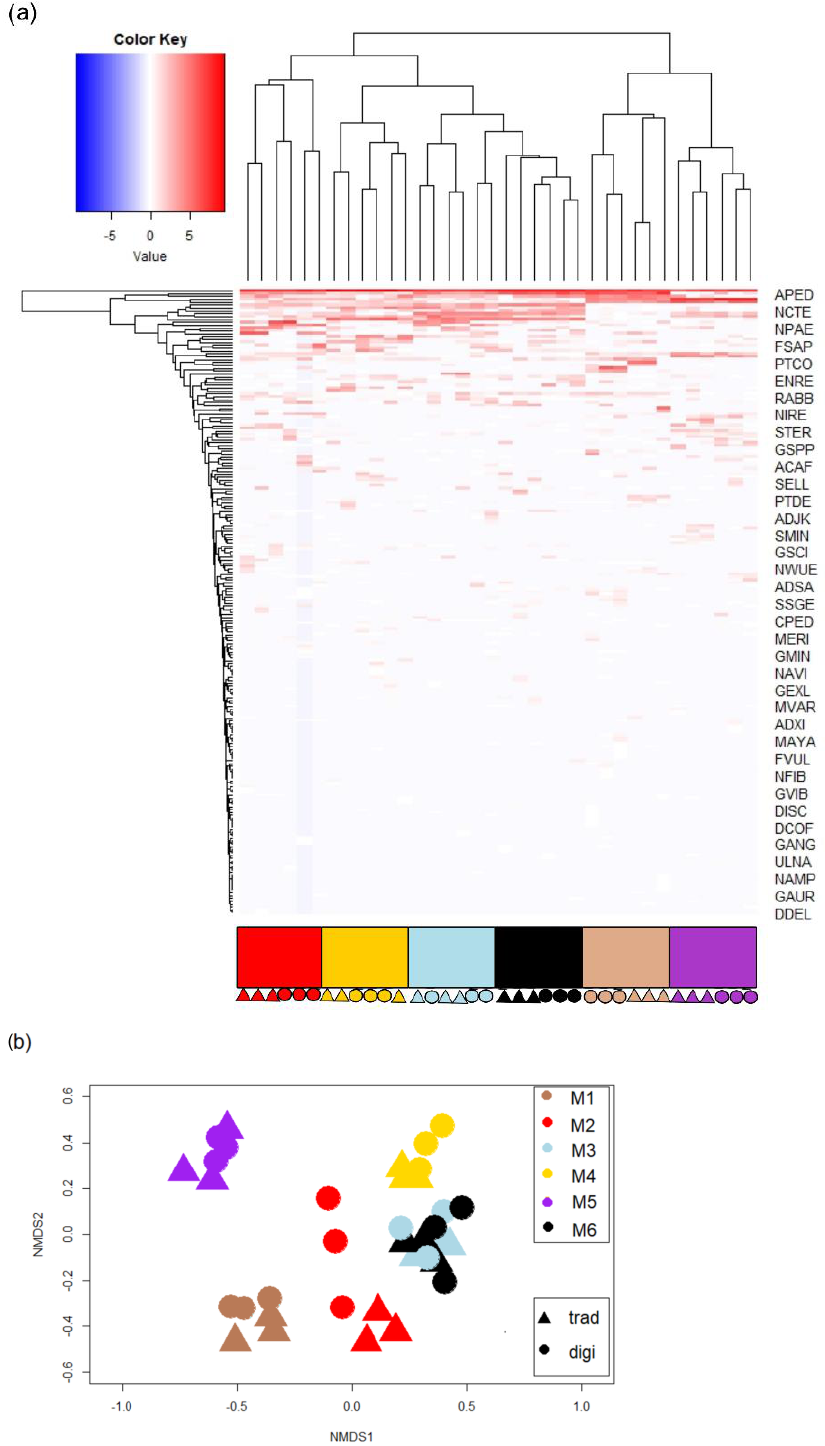
Figure 4. Diatom species composition [log (relative abundance + 1)] and sites ( a ) using a hierarchical cluster analysis, and ( b ) ordination by non-metric multidimensional scaling. Triplicates of the same sample cluster together, without a separation by counting method, only counts obtained from sample M2 (red) using digital microscopy show a wider spread. Four letter code explained in Supplement Table S1. Table 2. Post-hoc Tukey HSD analysis to test the intra-site variation of species richness community structure according to method on the complete and the reduced dataset. In bold, significant values.